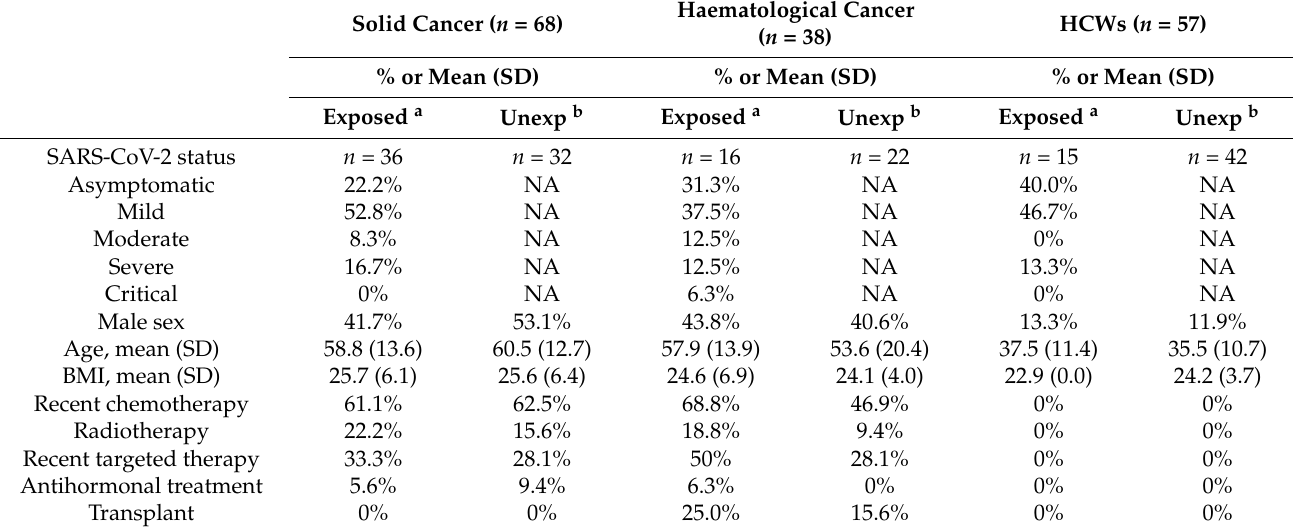
Table 1. Patient characteristics